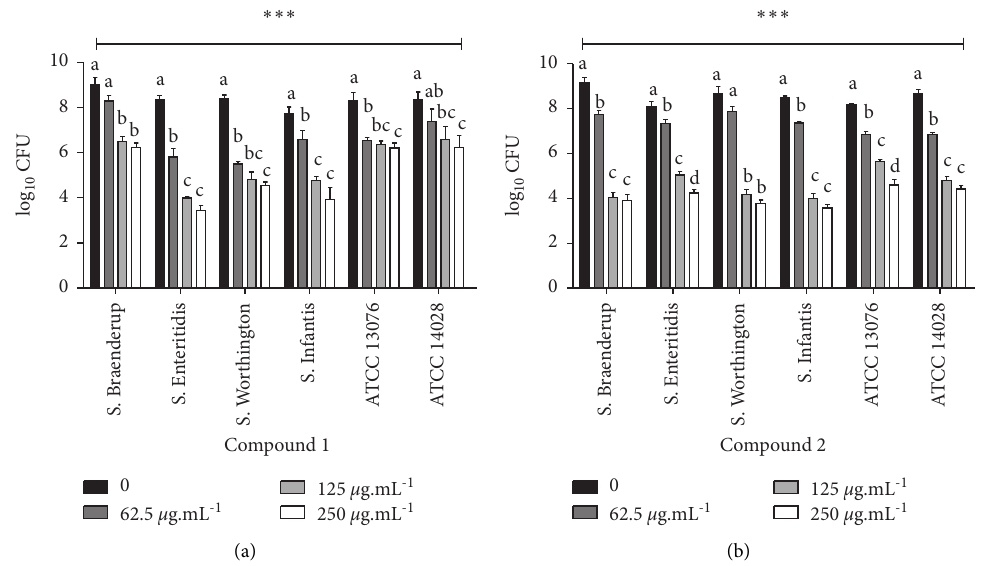
Figure 2: Antibiofilm activity of 4, 5-dihydro-1H-pyrazole-1-carboximidamide hydrochlorides (trifluoromethyl)phenyl-substituted, compound 1 and bromophenyl-substituted, compound 2 , using ANOVA and Tukey’s test. ∗∗∗ ( p < 0 . 05) indicates a significant difference. Different letters for each concentration represent a significant difference between them by the means test ( p < 0 . 05).